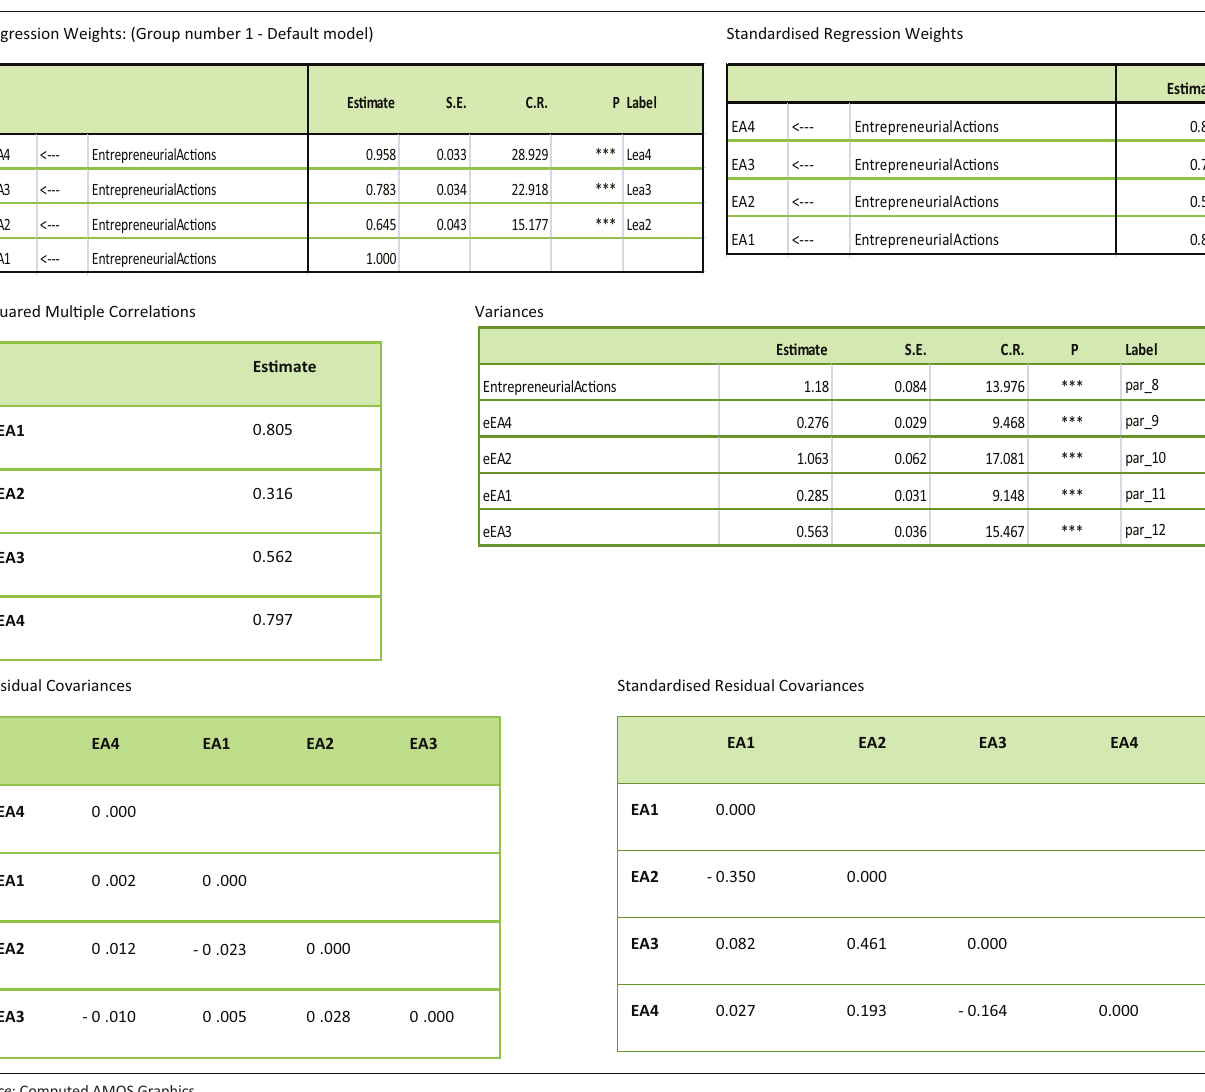
FIGURE 4: Parameter estimates for Confirmatory Factor Analysis model for entrepreneurial actions.